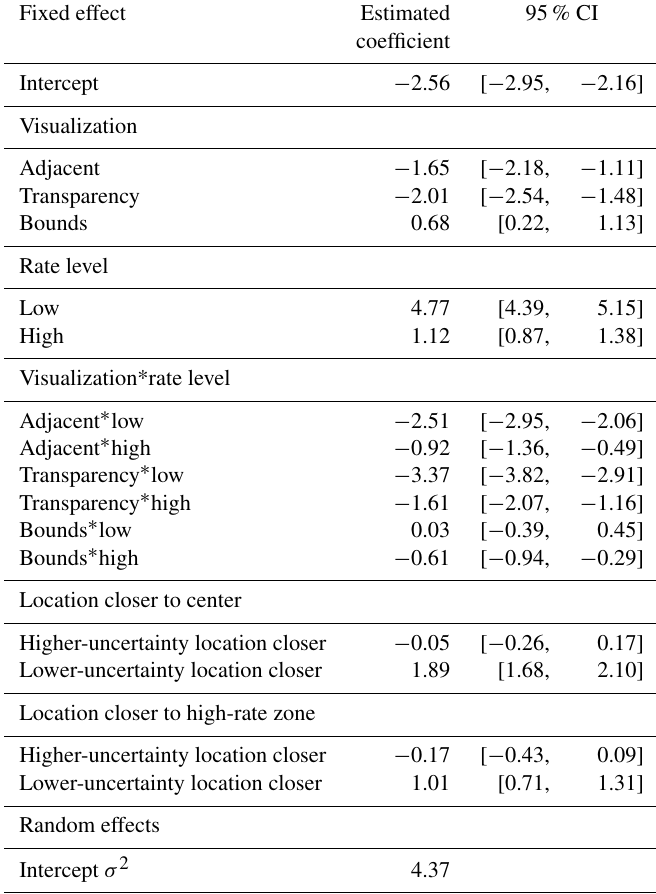
Table 5. Most likely estimates and 95% confidence intervals using Wald standard errors for fixed effects in the best-fitting multilevel model. The intercept is the logistic of the probability of selecting the higher-uncertainty location for the Rate Only condition and medium-rate trials, with both locations being equidistant from map features (reference level for visualization, rate level and the map feature variables). Each fixed effect gives the change in probability of selecting this location from Rate Only to UV conditions, from medium rate to other rate levels or from equidistant locations to one location being closer to the map feature (all else being held